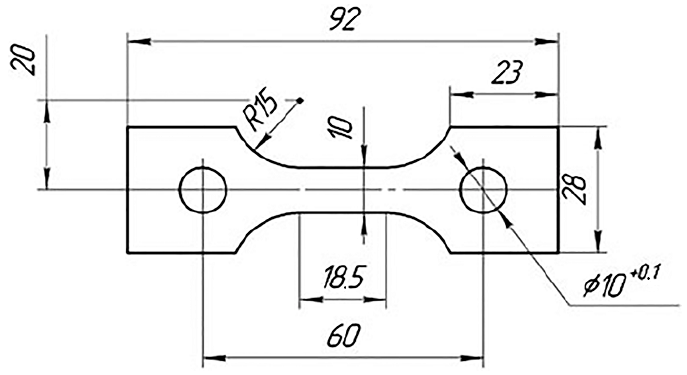
Figure 1. Test specimen (in mm).